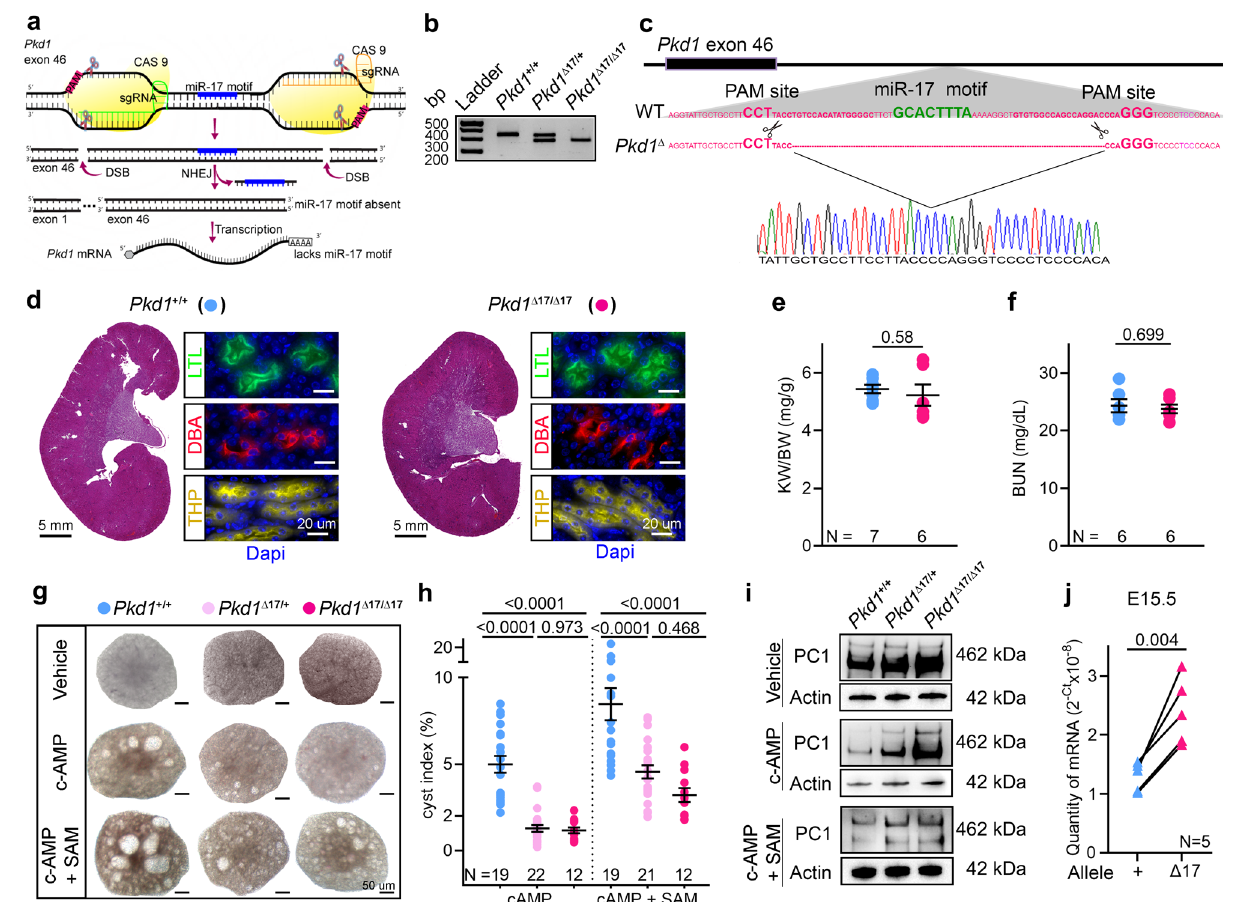
Pkd1 +/+ and Pkd1 Δ 17/ Δ 17 mice. e – f Normal kidney-weight-to-body-weight (KW/BW) and serum blood urea nitrogen (BUN) levels in 8-week-old Pkd1 +/+ and Pkd1 Δ 17/ Δ 17 mice. g – h Images and cyst index quanti fi cation of E13.5 Pkd1 +/+ , Pkd1 Δ 17/+ , and Pkd1 Δ 17/ Δ 17 kidneys grown for four days in culture media containing vehicle, 100 uM cAMP, or 100 uM cAMP plus 250 uM SAM. i Immunoblots depicting PC1 expression in Pkd1 +/+ , Pkd1 Δ 17/+ , and Pkd1 Δ 17/ Δ 17 ex-vivo kidneys treated with vehicle, cAMP, or cAMP plus SAM. Actin is used as the loading control. j Allele-speci fi c qRT-PCR showing the quantity of Pkd1 mRNAs produced by the wildtype (+) and Δ 17 alleles in E15.5 Pkd1 Δ 17/+ kidneys ( n =5). Error bars indicate SEM. Statistical analysis: Two-tailed Student ’ s t -test ( e , f ); One-way ANOVA, Tukey ’ s multiple- comparisons test ( h ); Two-tailed Paired t -test ( j ). Source data are provided as a Source Data fi